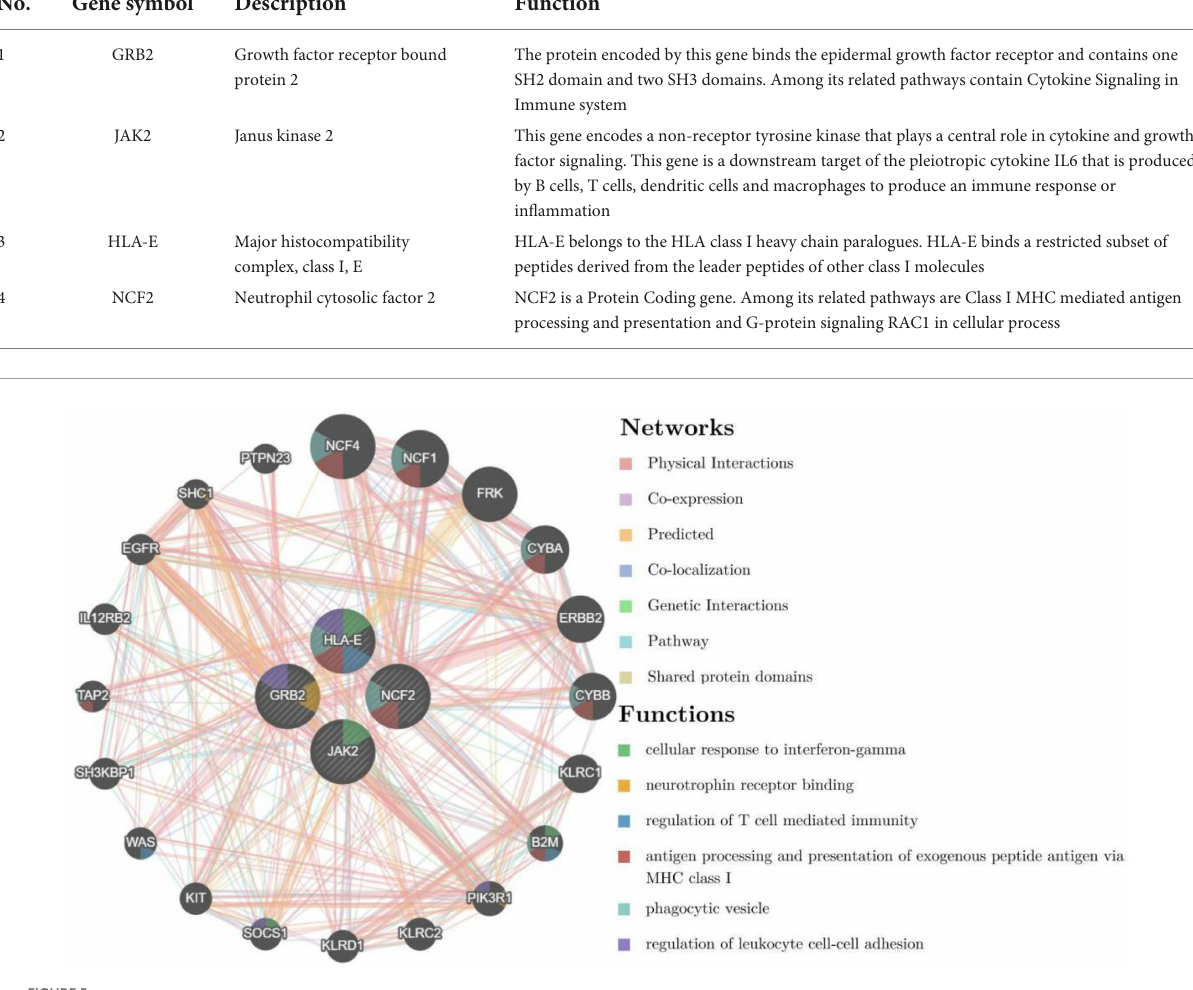
TABLE 2 The details of the validated hub genes.